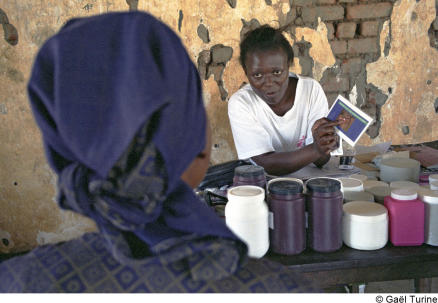
A health worker explains to a patient how to use a miconazole gum patch(Photo: Gaël Turine)